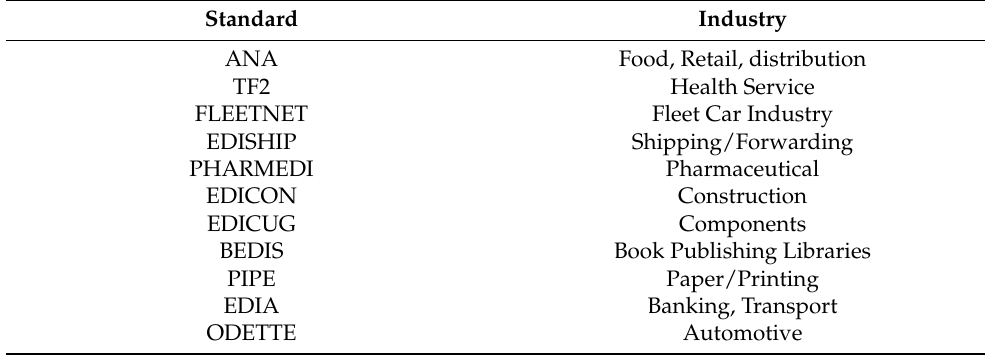
Table 1. Industries using